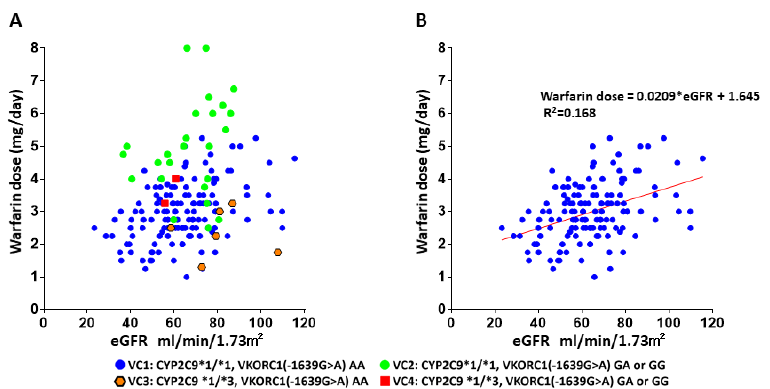
Figure 2. Scatter plots show the relationship between warfarin maintenance dose and eGFR: （ A ） Different symbols are used to distinguish among genotypes (blue plots, VC1: CYP2C9 *1/*1 and VKORC1 [-1639G>A] AA ; light green plots, VC2: CYP2C9 *1/*1 and VKORC1 [-1639G>A] GA or GG ; orange plots, VC3: CYP2C9 *1/*3 and VKORC1 [-1639G>A] AA ; red plots, VC4: CYP2C9 *1/*3 and VKORC1 [-1639G>A] GA or GG ). (B) The red line shows a linear regression line for the only VC1 group ( n =140, CYP2C9 *1/*1 and VKORC1 [-1639G>A] AA ). The warfarin maintenance dose = 0.0209*eGFR [ml/min/1.73m2] + 1.645, R2 = 0.168, p value <0.001). eGFR: estimated glomerular filtration rate.